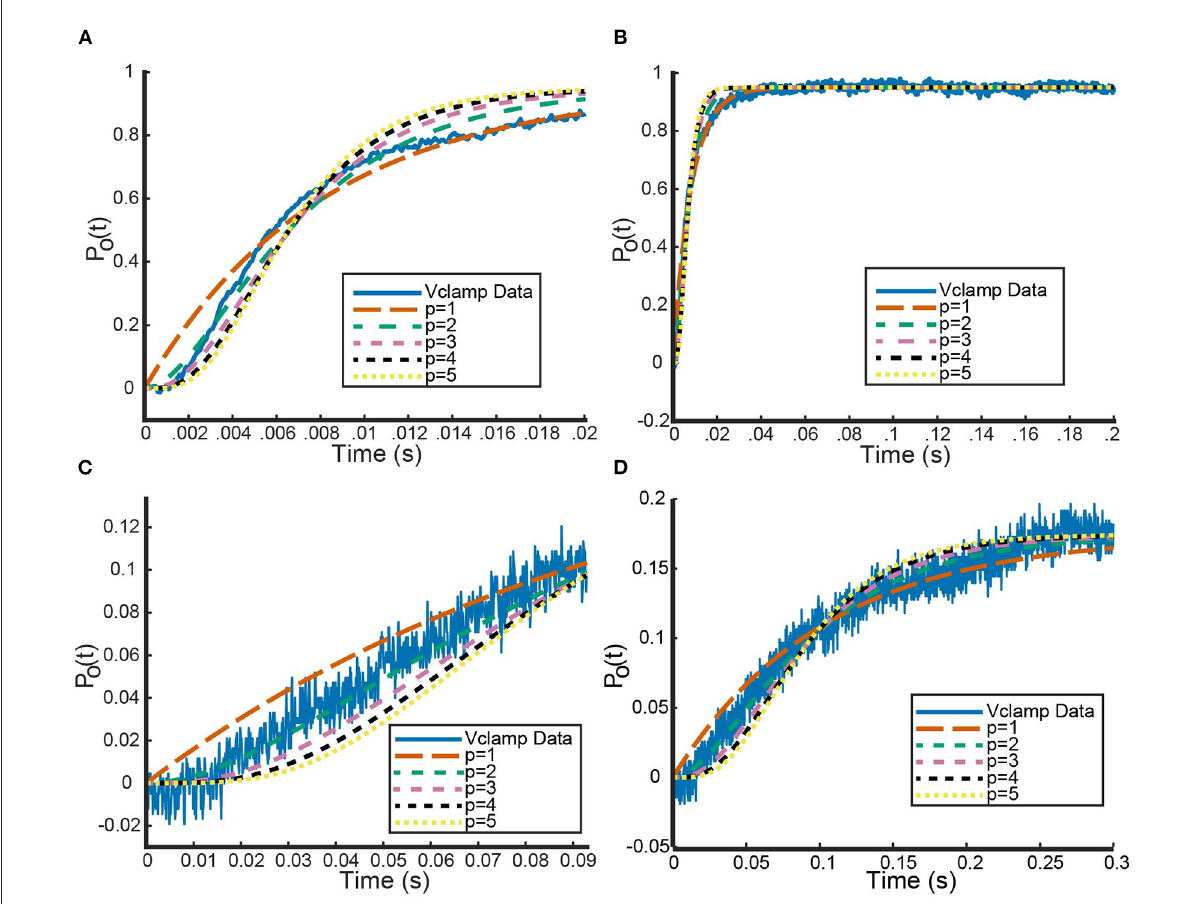
FIGURE1 Sample fits of five curves of the form seen in Equation (14) to voltage clamp data (shown in blue) from Channelpedia (Ranjan et al., 2011, 2019). Each curve corresponds to a different value of p , the number of gates being used to fit the data. (A,C) A zoomed in version to make clear the performance of each model on capturing the sigmoid shape of the beginning portion of the data. (B,D) The whole timescale with each of the five fits. Curve colors are as follows: p = 1 (orange), p = 2 (green), p = 3 (pink), p = 4 (black), p = 5 (yellow). Curve dash sizing and spacing is given in figure legend. (A,B) correspond to a voltage step from − 90 up to 20 mV while panels (C,D) correspond to a voltage step from − 90 up to − 30 mV.